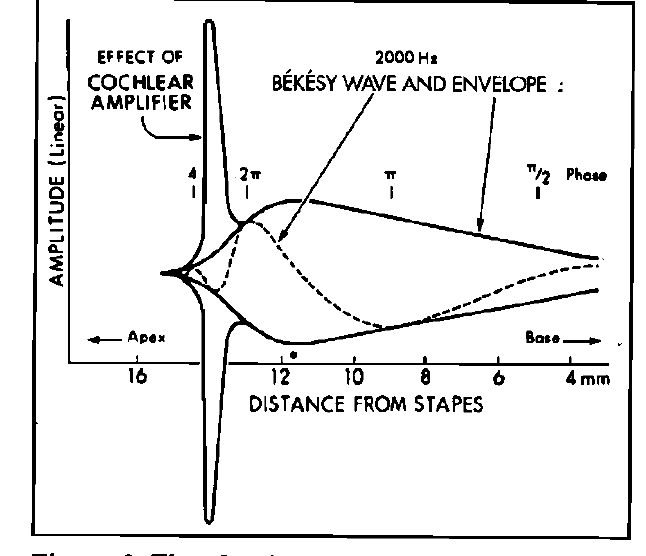
Figure 2. The classic travelling wave and its en- velope is presented together with the cochlear amplifier. Note the frequency difference in ampli- tude peaks between the two (after Davis, 1983, p.